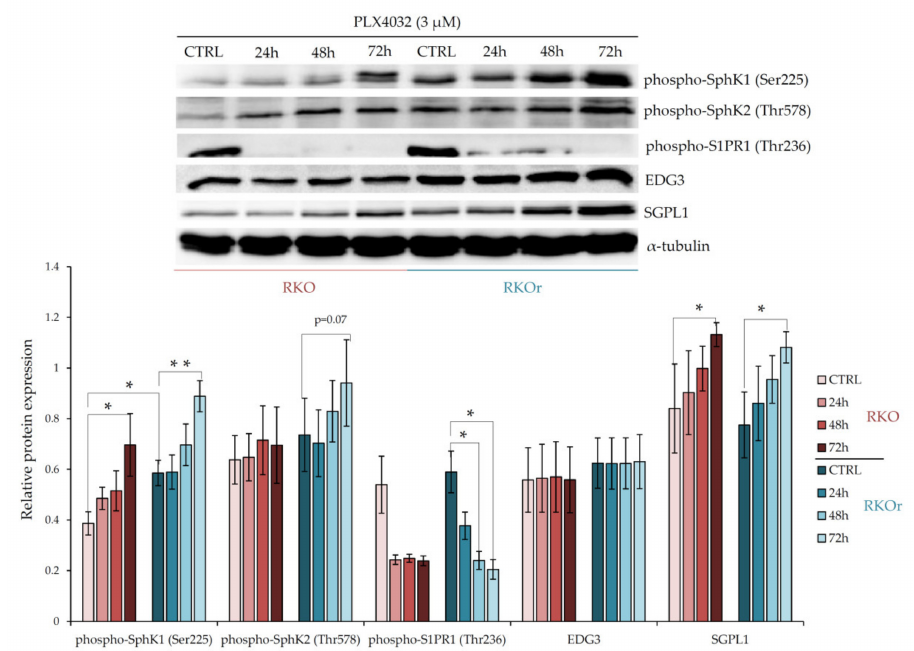
Figure 1. Time-dependent changes in relative expression of the enzymes regulating S1P metabolism and signalling in sensitive (RKO) and resistant (RKOr) cells treated with PLX4032 (3 µ M). Relative protein expression was measured using Quantity One software for densitometry analysis of western blot bands. Data represent mean and standard deviation obtained from three independent biological experiments. α -tubulin was used as loading control. Statistical significance is denoted with an asterisk (* p < 0.05, ** p < 0.01). SphK1 (Sphingosine kinase 1), SphK2 (Sphingosine kinase 2), S1PR1 (EDG1, sphingosine-1-phosphate receptor 1), EDG3 (S1PR3, sphingosine-1-phosphate receptor 3), SGPL1 (sphingosine-1-phosphate lyase